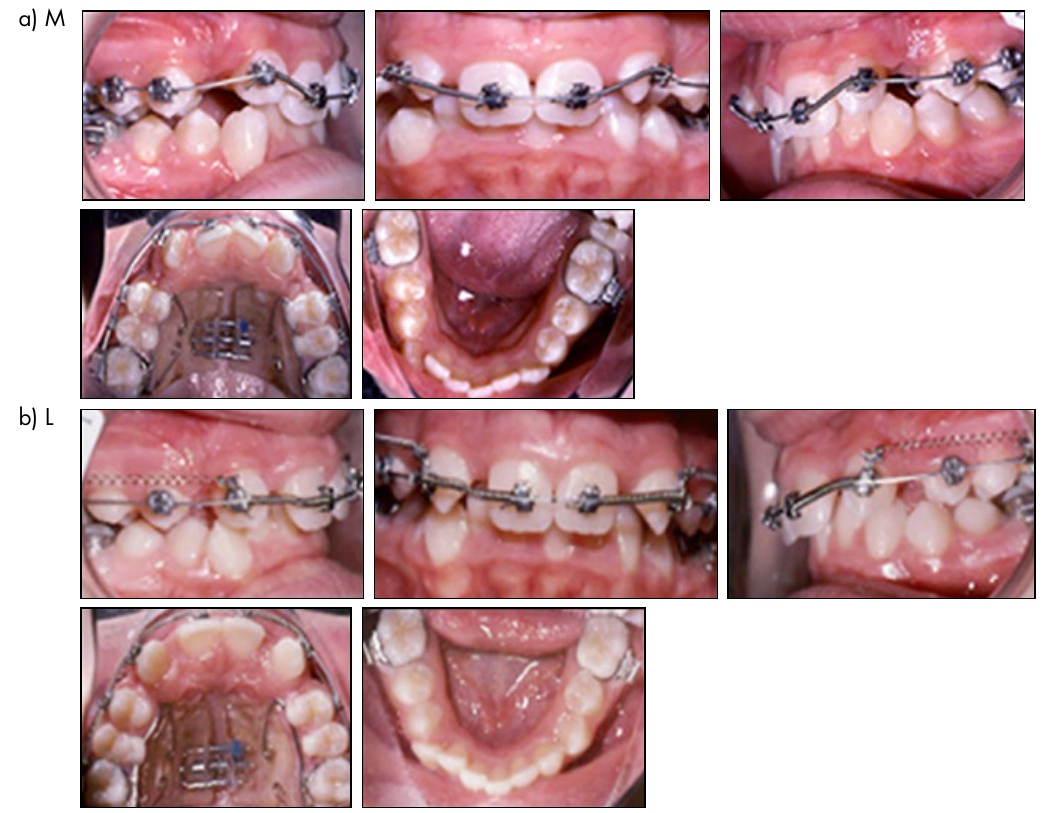
Figure 7. Rapid palatal expansion appliance and initial wire on the upper arch to align and intrude the upper anterior